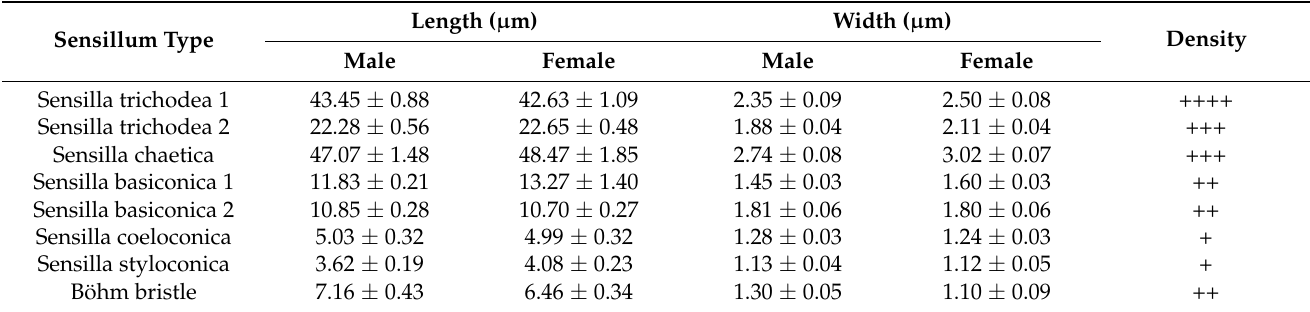
Table 3. Lengths, widths, and density of various adult O. communa antennal sensilla. + to ++++ indicate relative density of different